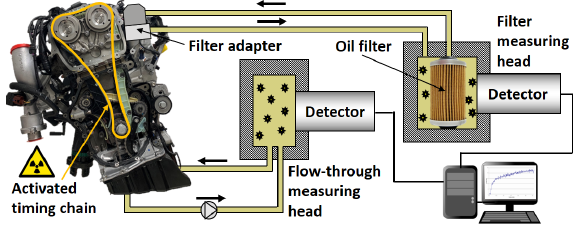
Figure 3. Online wear measurement of a timing chain using an RNT measuring